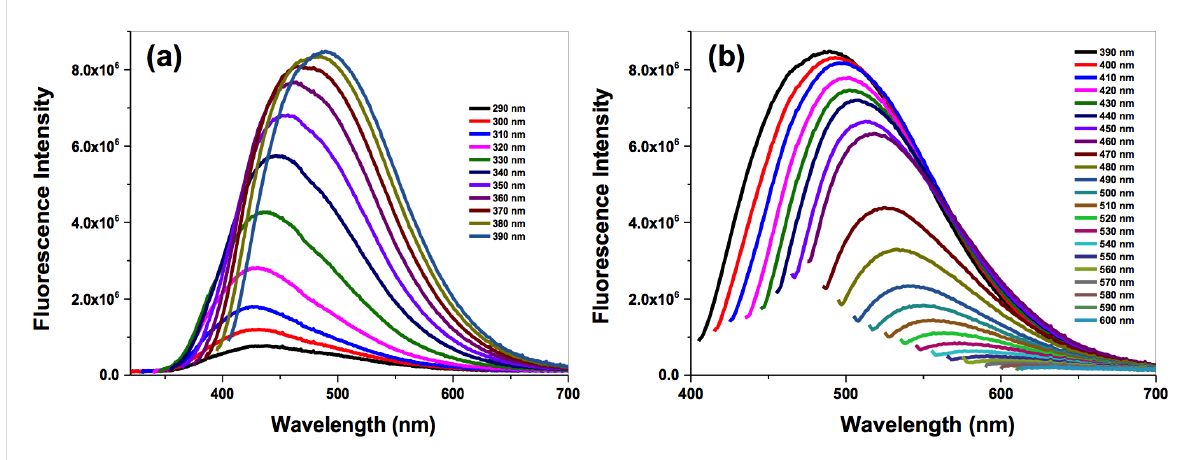
Figure 2: Emission spectra of black pepper C-dots under different excitation wavelengths (a) from 290 to 390 nm and (b) from 390 to 600 nm. Optimum selected conditions are λ ex / λ em : 390/489 nm.